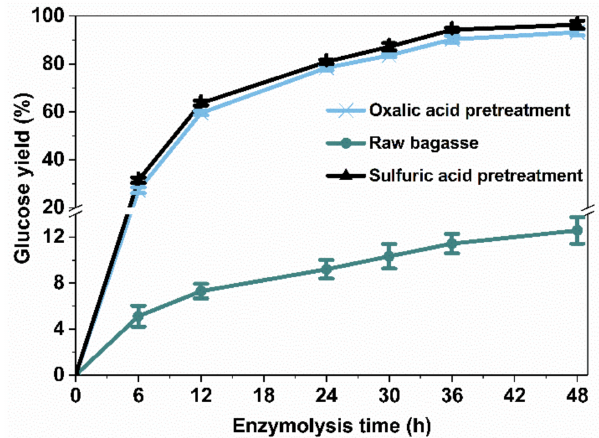
Figure 7. Time profiles of the enzymatic hydrolysis of raw bagasse and bagasse when pretreated with different